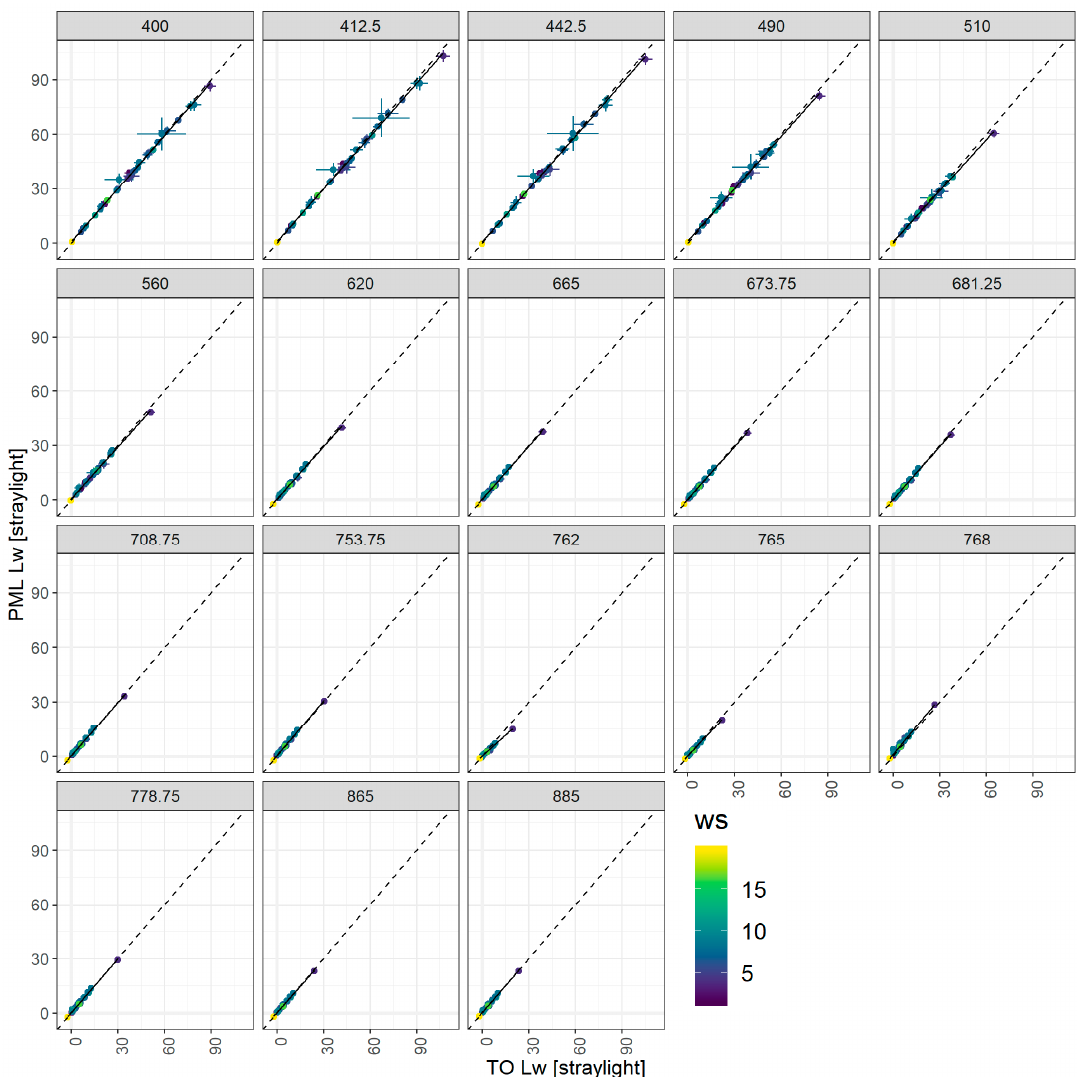
Figure A6. Comparison between TO and PML L w ( λ ) after straylight correction at OLCI’s bands.